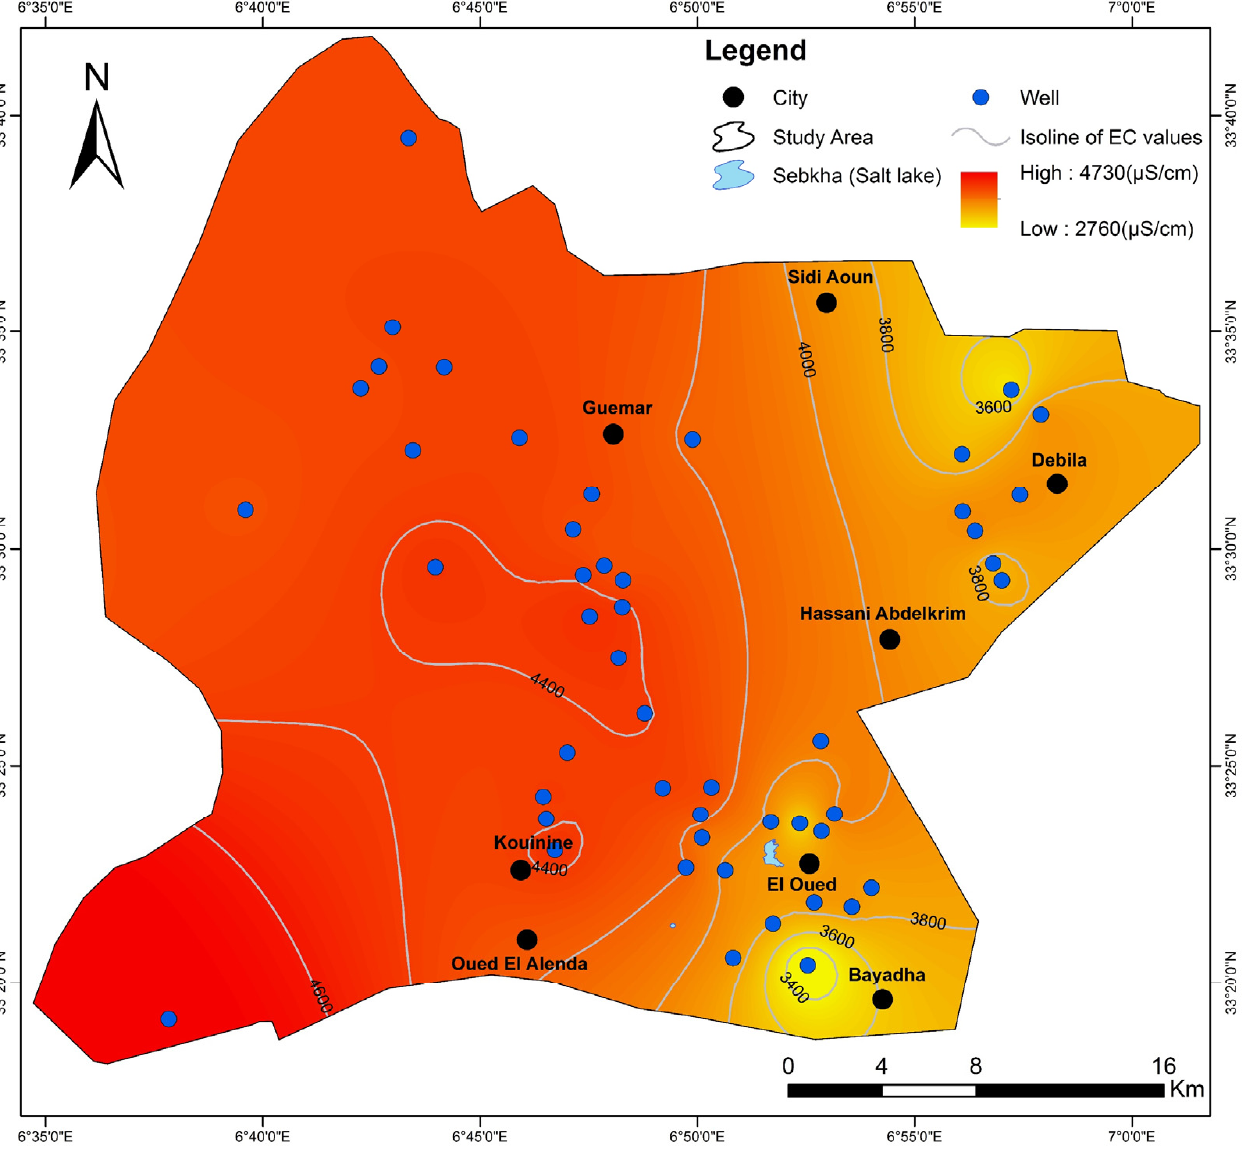
Figure 7. Spatial distribution of EC. The dissolution of evaporate formations, the leaching of clays, and the dissolution of gypsum and anhydrite are the main factors that control the spatial distribution of SO 42 − and Mg 2+ . Low values were found in the north of the study area around Sidi Aoun and Guemar, while the highest values were observed in the southwest of the study area. The lowest values of Mg 2+ were located near Guemar, southwest of Debila, south of El Oued, and Kouinine. Furthermore, a high value was also noted in the southwest, as shown in Figures 8B and